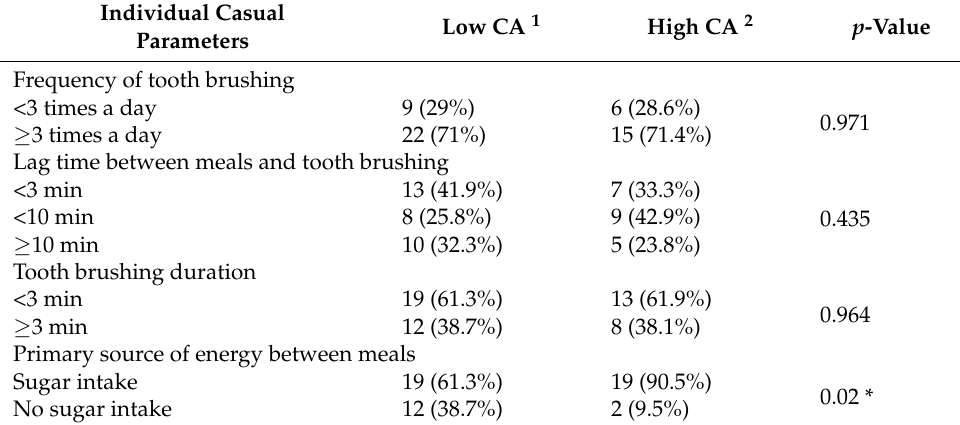
Table 4. Comparison of individual casual parameters by the significant caries